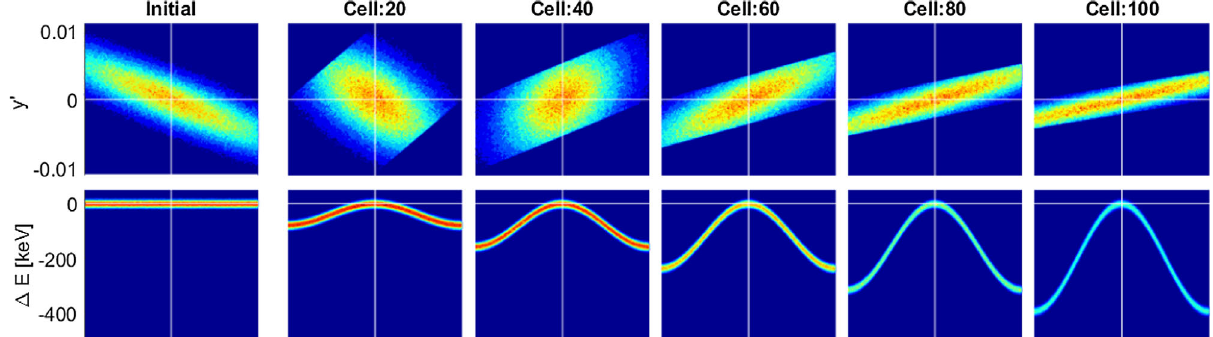
FIG. 17. Evolution of the y and z phase spaces. The axes are − 400 nm < y < 400 nm and 0 < φ < 2 π . Again, the color represents the phase space density, normalized to the second column.